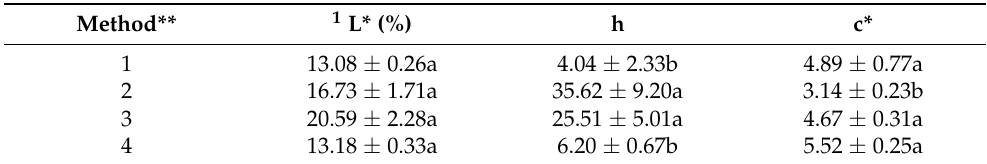
Table 2. Color parameters of the pectins obtained from jabuticaba peel using different extraction methods.